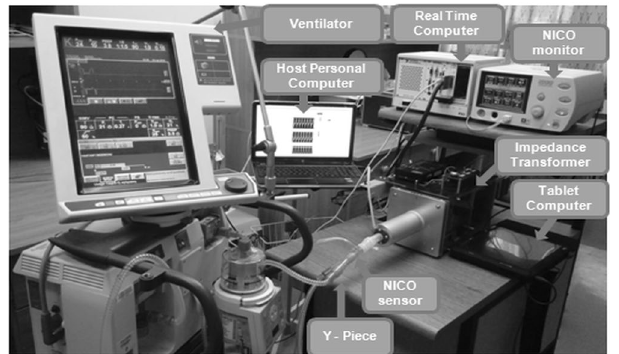
Figure 1. Measuring set-up. Infant Hybrid Respiratory Simulator (IHRS), ventilator and NICO monitor of respiratory parameters sent to Tablet Computer. IHRS consists of an Impedance transformer, Real-Time Computer and Host Personal